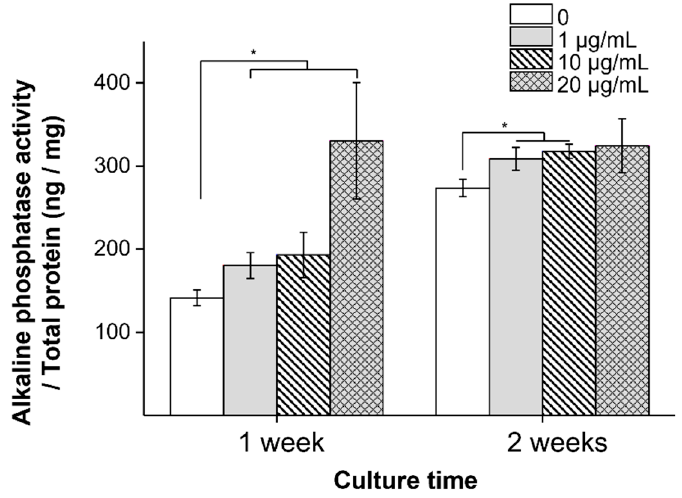
Figure 4. ALP activity of hMSCs for MXene concentration content after 7 days and 14 days incubation (* p < 0.05).